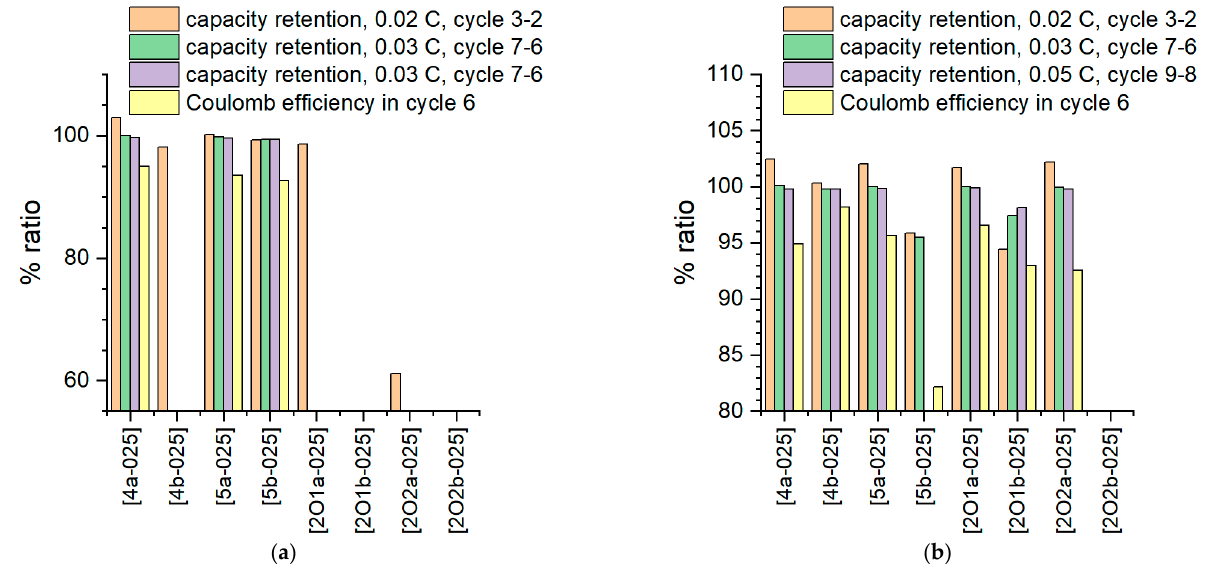
Figure 11. Cycle test in battery cells. ( a ): half cell, Li vs. LFP; ( b ): full cell, LTO vs. LFP; current rates as specified.